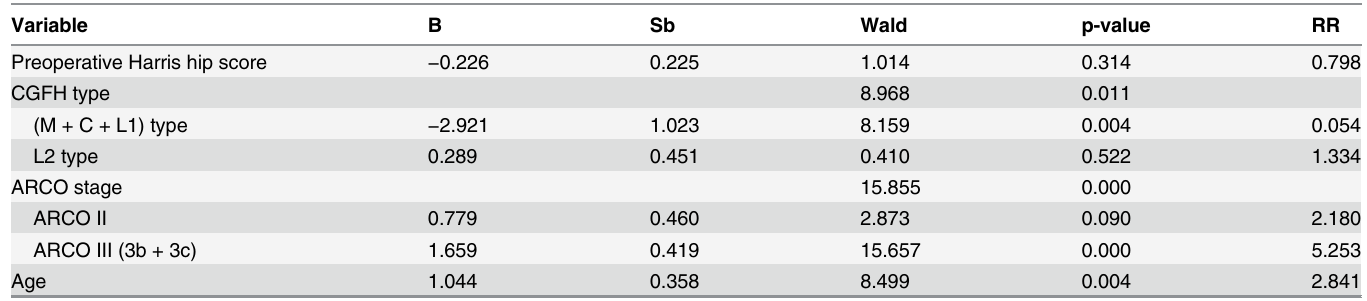
Table 2. Multivariate cox regression analysis results.